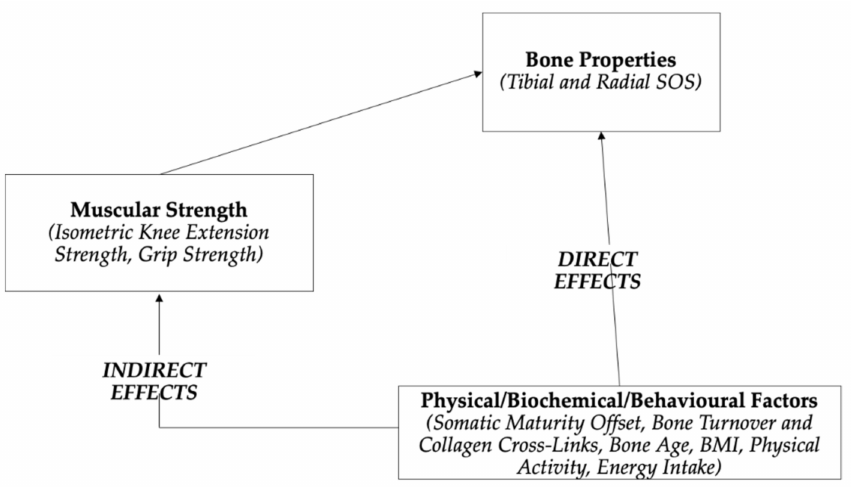
Figure 1. Modified functional model of bone development in children and adolescents. Items in italics are variables used to reflect each